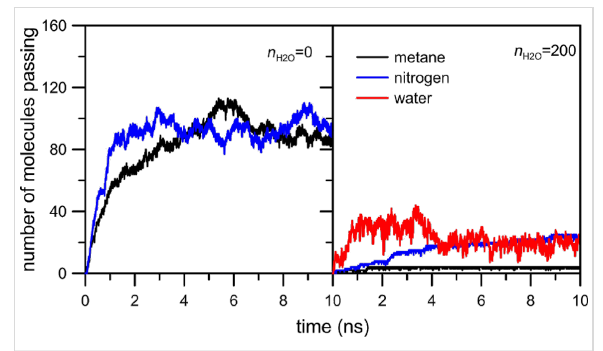
Figure 7: The influence of water on the number of methane and nitrogen molecules passing through NN nanopore.